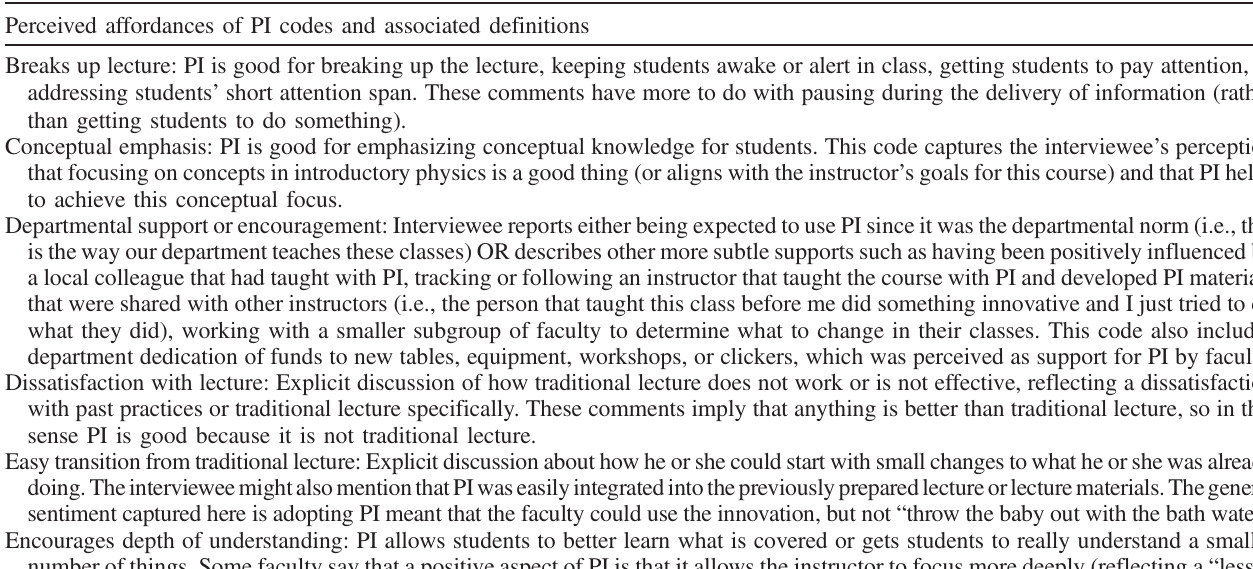
Table VI below summarizes our code definitions of reasons faculty give for aligning their instruction with Peer Instruction (or elements of PI). TABLE VI. Definitions of perceived affordances of PI use codes